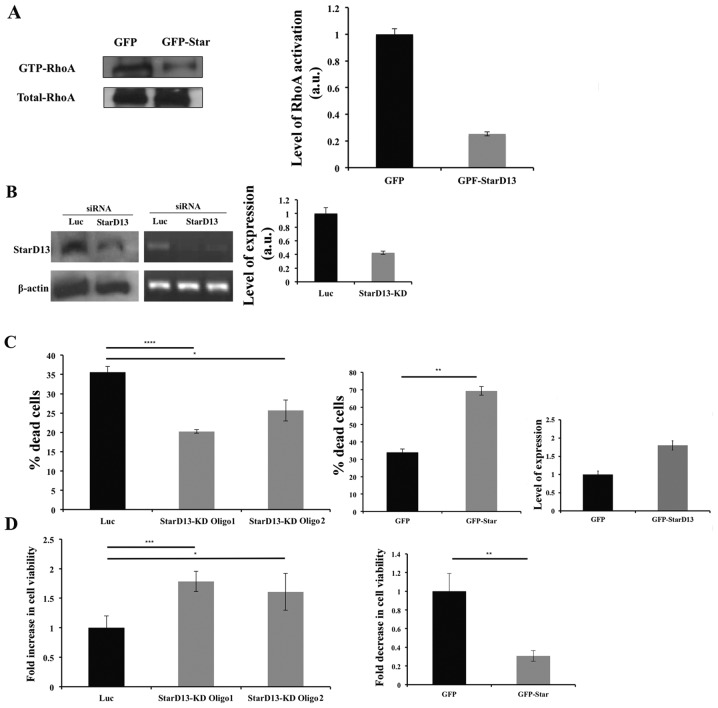
StarD13 on cell viability and proliferation. (A) MDA-MB-231 cells were transfected with either GFP alone (right lanes) or with GFP-StarD13 (left lanes). The cells were then lyzed and incubated with GST-RBD (Rhotekin binding domain) (upper pannels), or with GST-CRIB (Cdc42 and Rac interactive binding domain) (lower panels) to pull down active Rho and Cdc42, respectively. The samples were then blotted with Rho, and Cdc42 antibodies. The lower gels in each panel are western blots for the total cell lysates for loading control. The bands from the active RhoA gel were quantitated using ImageJ and normalized to the amount of total proteins. Data are the mean ± SEM of 3 blots from 3 independent experiments. (B) MDA-MB-231 cells were transfected with luciferase control siRNA or with StarD13 siRNA for 72 h. Two different siRNA oligos against StarD13 were used in each experiment. The cells were lysed and immunoblotted by western blot analysis for StarD13 (left upper gel) or for actin (left lower gel) for loading control. Quantitation represents 3 different blots from independent experiments. RT-PCR was also performed to detect StarD13 level using StarD13 primer (right upper gel) and actin as loading control (right lower gel). (C) Percentage (%) of dead cells was determined using trypan blue, results are shown as percent of total number of cells (left panel). Cells were transfected with GFP-StarD13 or GFP alone as control for 24 h. The percentage of dead cells showed an increase of 50% as determined using trypan blue (middle panel). Right panel is a quantitation from 3 different blots of cells transfected with either GFP or GFP-Stard13 and blotted for Star. (D) Cell proliferation was determined using WST-1 reagent. Cell viability of siRNA-transfected cells was expressed as fold increase from control (right panel). Cell proliferation dramatically decreased in cells transfected cells with GFP-StarD13 construct as opposed to control cells (right panel). Data are the mean ± SEM from 3 different experiments. *p<0.02, ***p<0.001, ****p<0.0001.